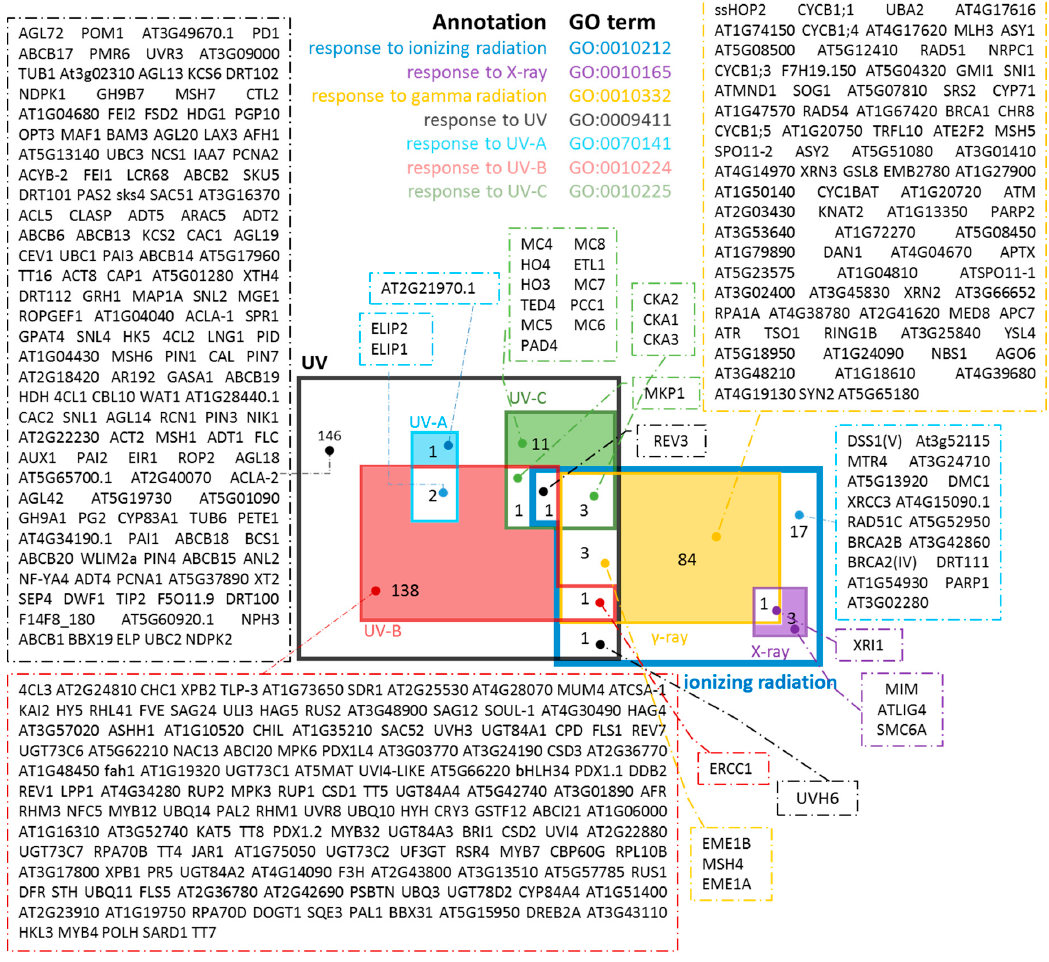
Figure 2. Preliminary screening of suitable genes. Venn diagram of retrieved orthologous genes from all different plant species and for specific GO (Gene Ontology) terms. The colored regions are the suggested gene pools used for further screening, as described in Figure 3.